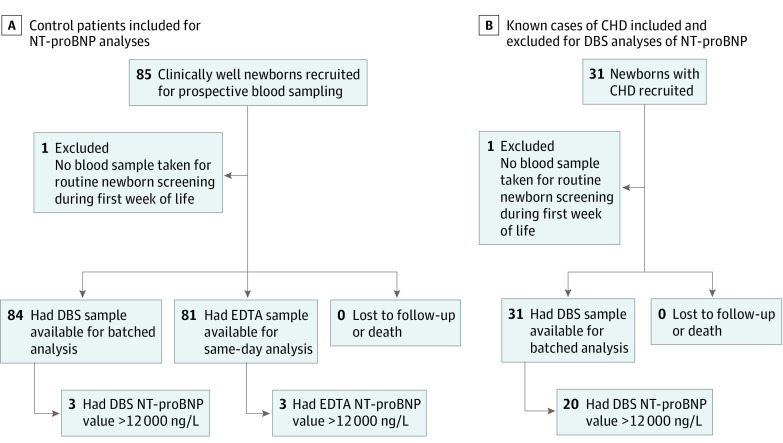
Study Flow Diagram for Control and Congenital Heart Disease (CHD) GroupsA, Two of 3 newborns with dried blood spot (DBS) results greater than 12 000 ng/L had minor congenital heart disease (CHD) (ie, patent ductus arteriosus, ventricular septal defect), and these results were identical to those identified by EDTA blood analyses; 1 result was a false positive. Three asymptomatic newborns with minor CHD were identified by EDTA amino terminal fragment of the prohormone brain-type natriuretic peptide (NT-proBNP) analyses using the initial cutoff at 12 000 ng/L based on previous references. B, DBS sampling was accidentally delayed by several weeks after heart surgery in 1 case of transposition of the great arteries. Exclusion did not alter the overall results of the study.